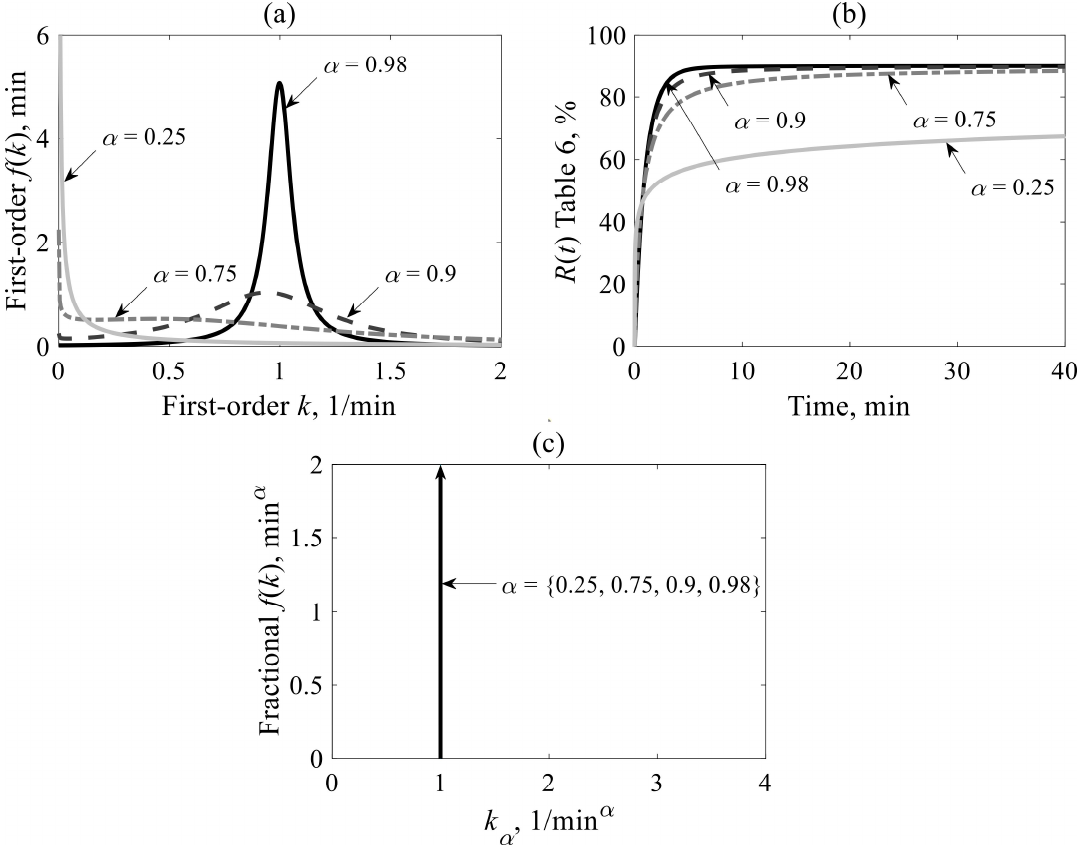
Figure 7. ( a ) First-order f ( k )s from the Fractional kinetics. ( b ) Time-recovery curves, Table 6. ( c ) Fractional f ( k )s.